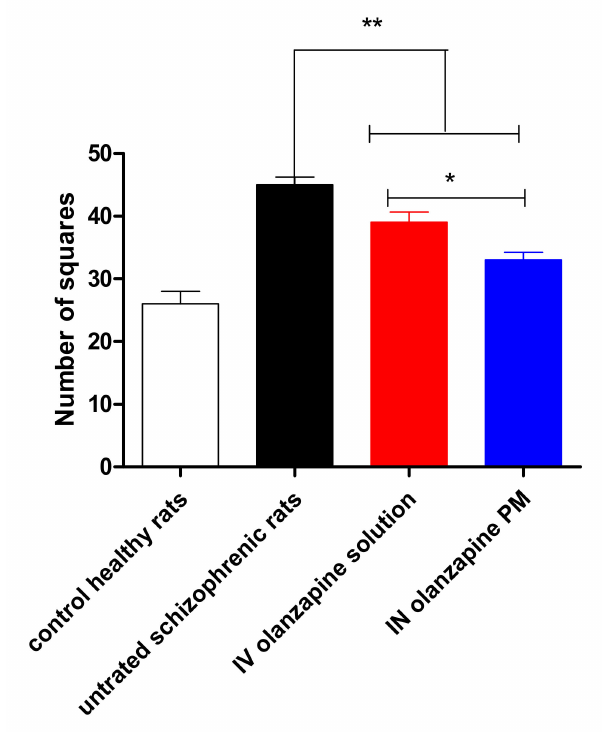
Figure 11. Assessment of pharmacodynamic effect of IV olanzapine solution and IN olanzapine PM in ketamine-induced schizophrenia in rats by open field test. *: p < 0.05; **: p <